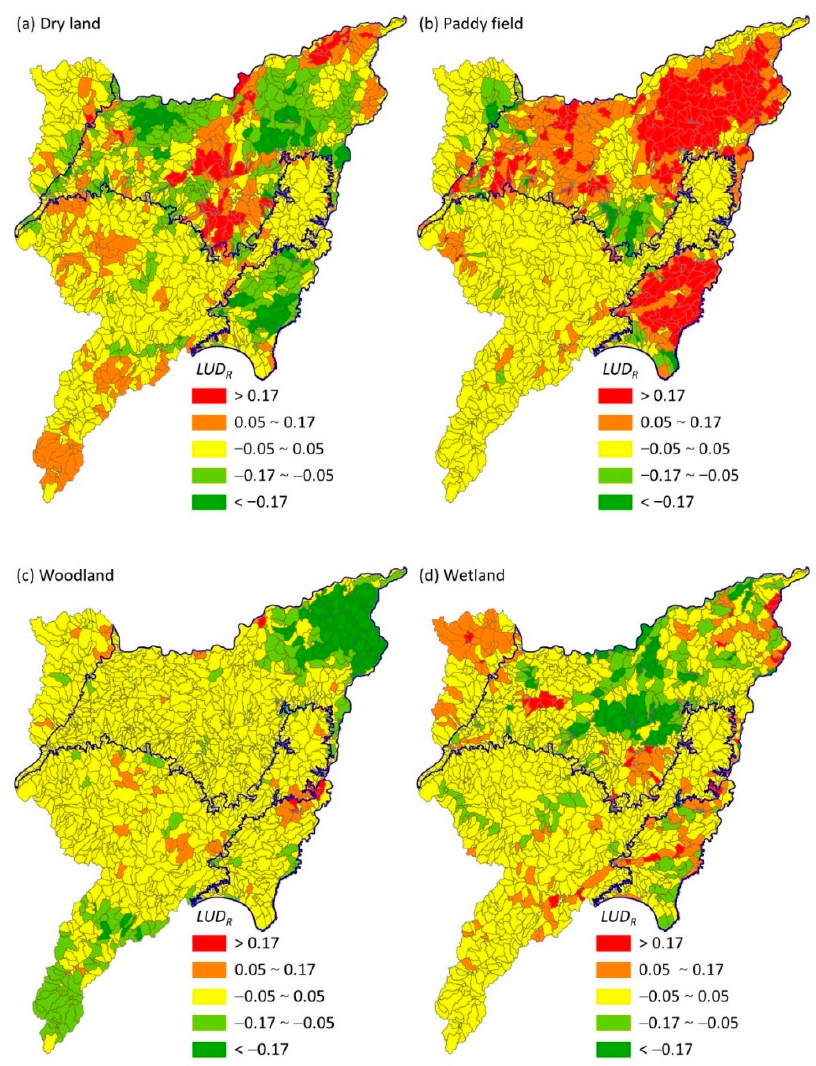
Figure 9. Comparison of predominant land use types between dynamic mode (15-year average from 2000 to 2014) and static mode (2000) at the sub-watershed scale of the Sanjiang Plain. The blue line is the boundary between the plain and hilly areas.